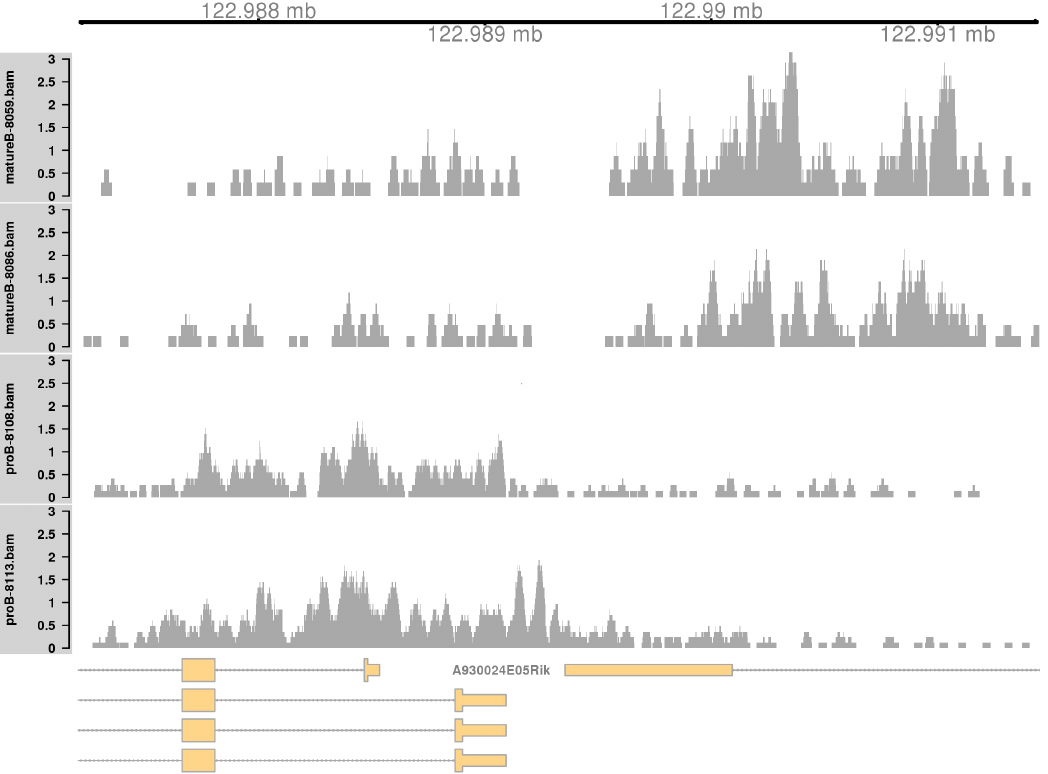
Figure 9. Coverage tracks for a complex DB event in the H3K9ac data set, shown as per-million